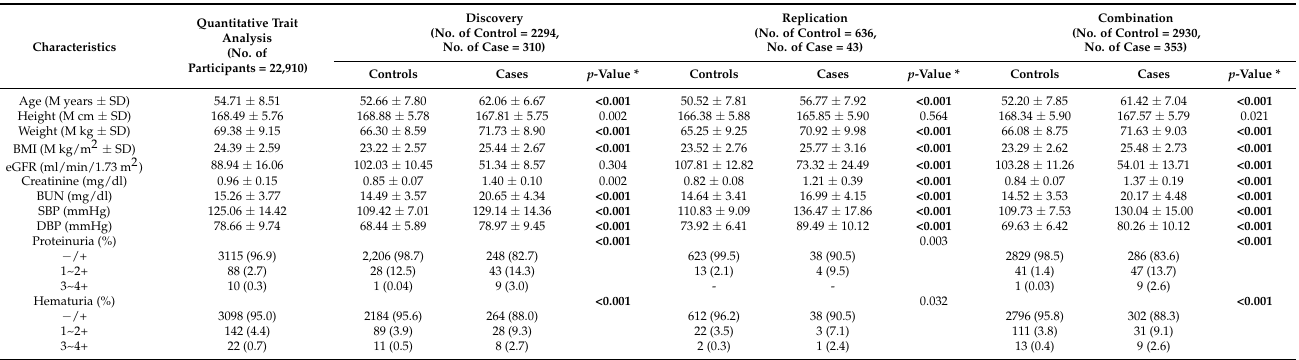
Table 1. Characteristics of male participants in this